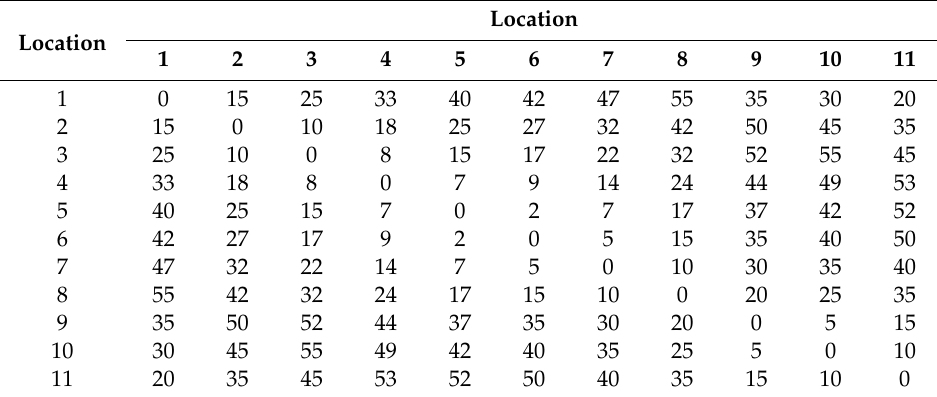
Table 2. Travel distance between locations.